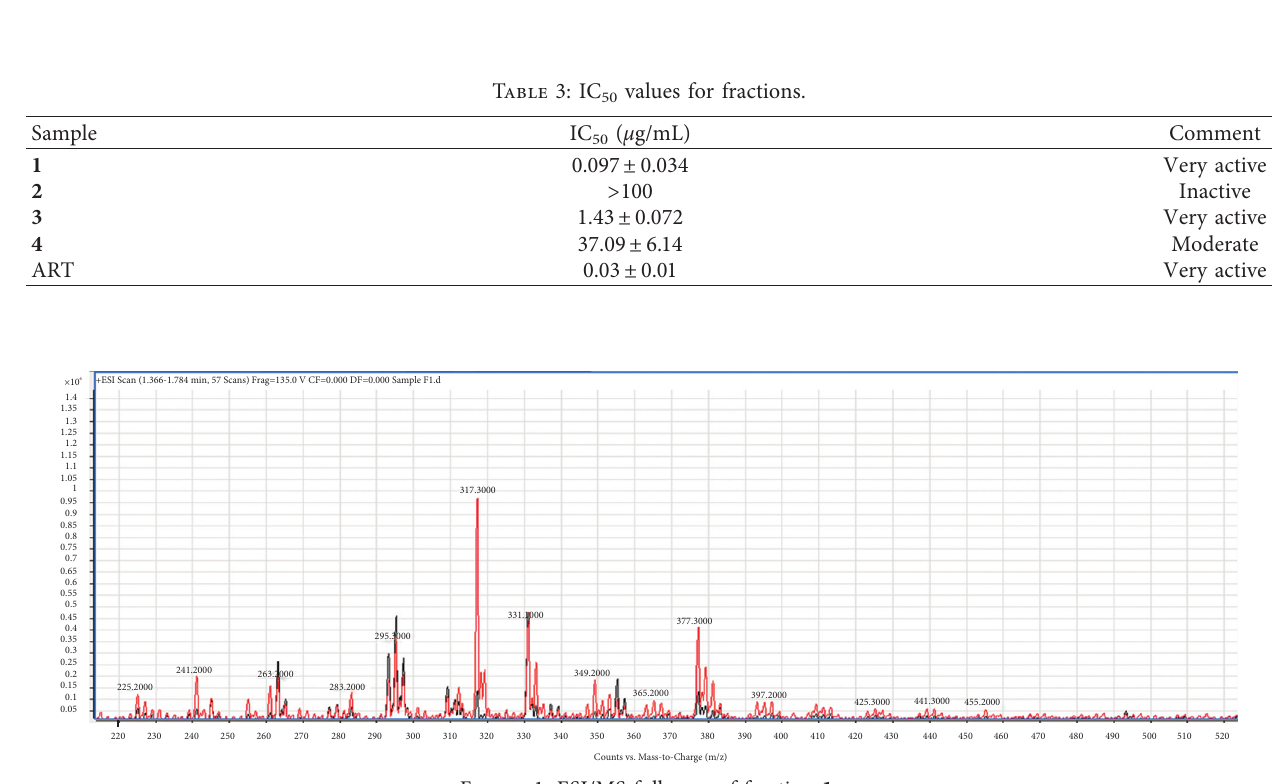
Figure 1: ESI/MS full scan of fraction 1